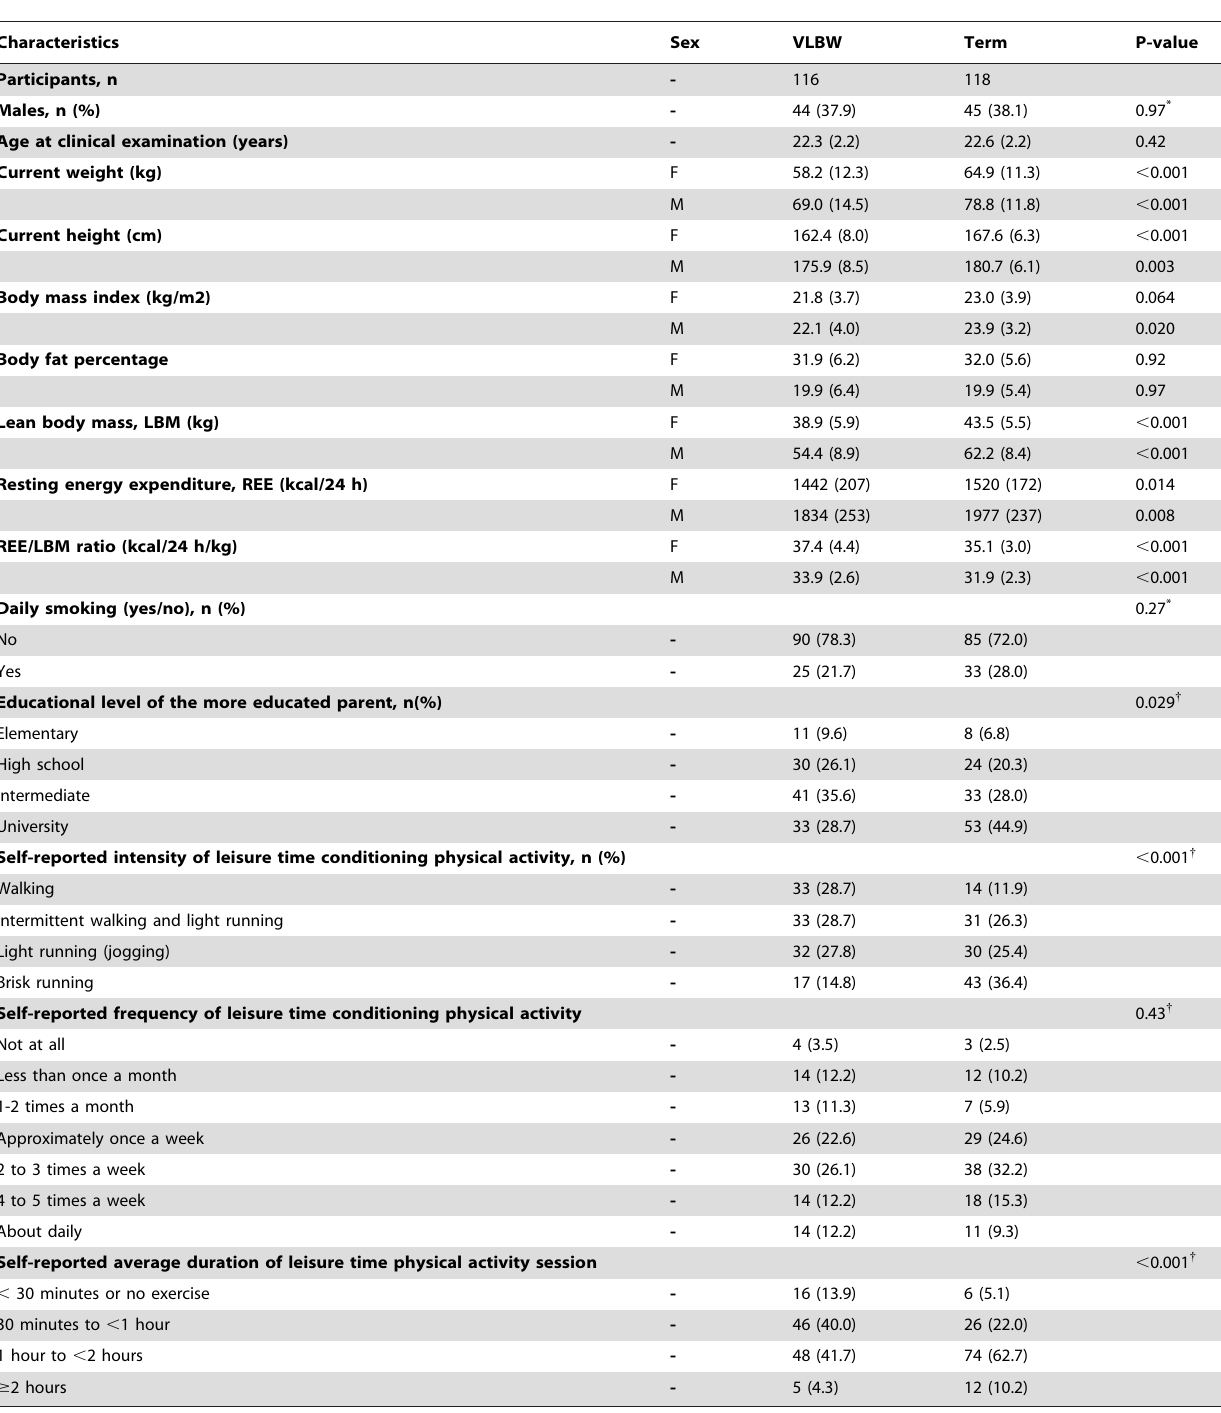
Table 2. Clinical characteristics of the young adults born with very low birth weight (VLBW; , 1500 g) and term born controls; the numbers represent mean (SD, standard deviation) or n